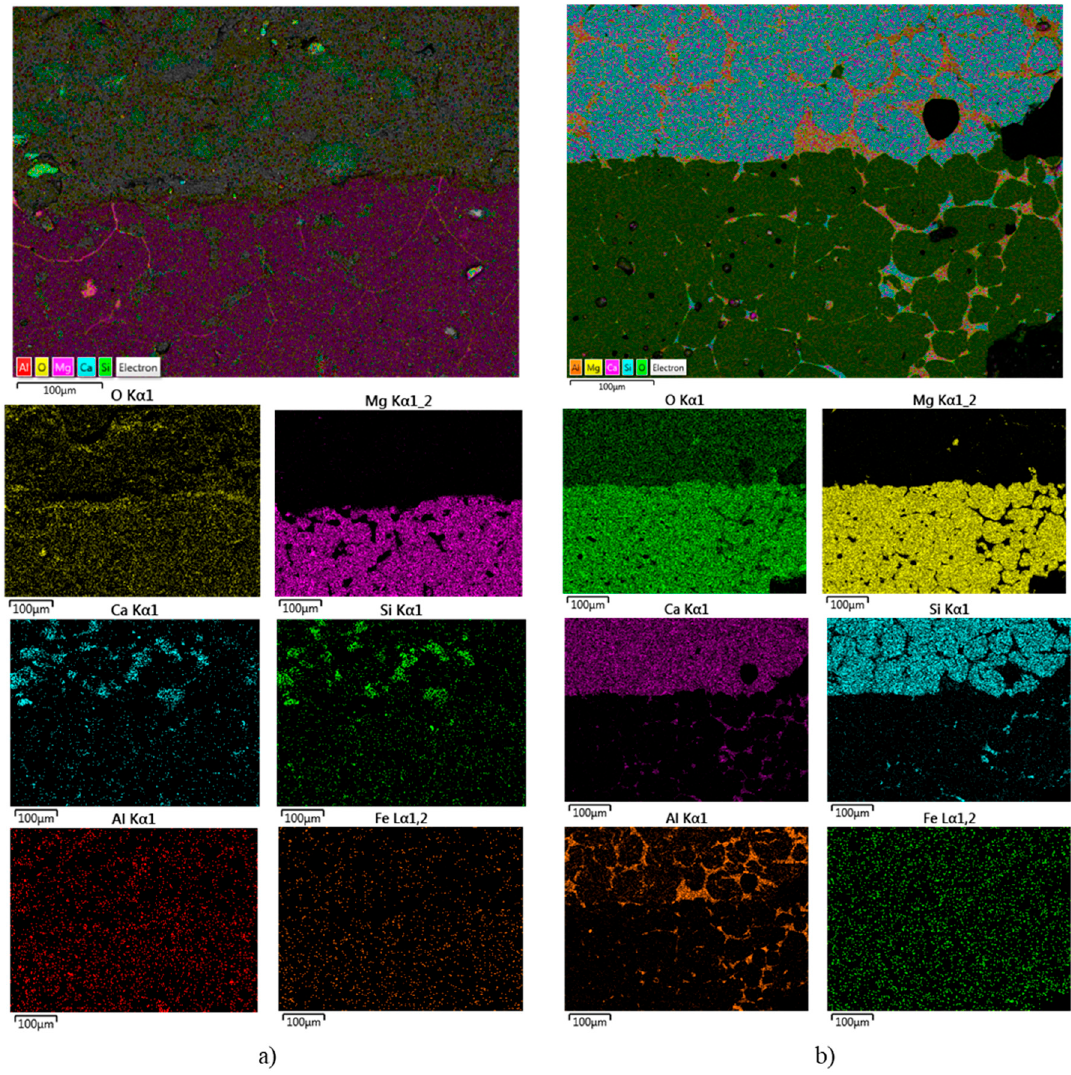
Figure 8. SEM micrograph of the clinker-brick interface of composition ( a ) A-1 ( b ) A-3 after the sandwich coating test— 200× magnification.